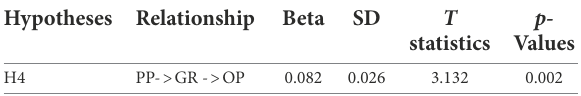
TABLE 6 Structural model assessment (indirect mediation).